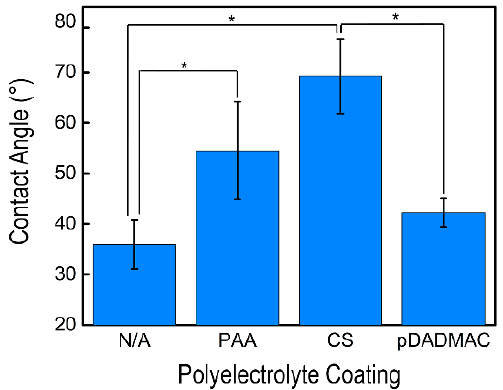
Figure 4. The average glycerol contact angle on cellulose nanofiber mats without functionalization (N/A) and functionalized with PAA, CS, and pDADMAC are shown. Error bars represent standard deviation, and the statistical significance determined using an unpaired t-test between samples is shown by an *. Contact angle measurements were acquired on N = 5 samples.